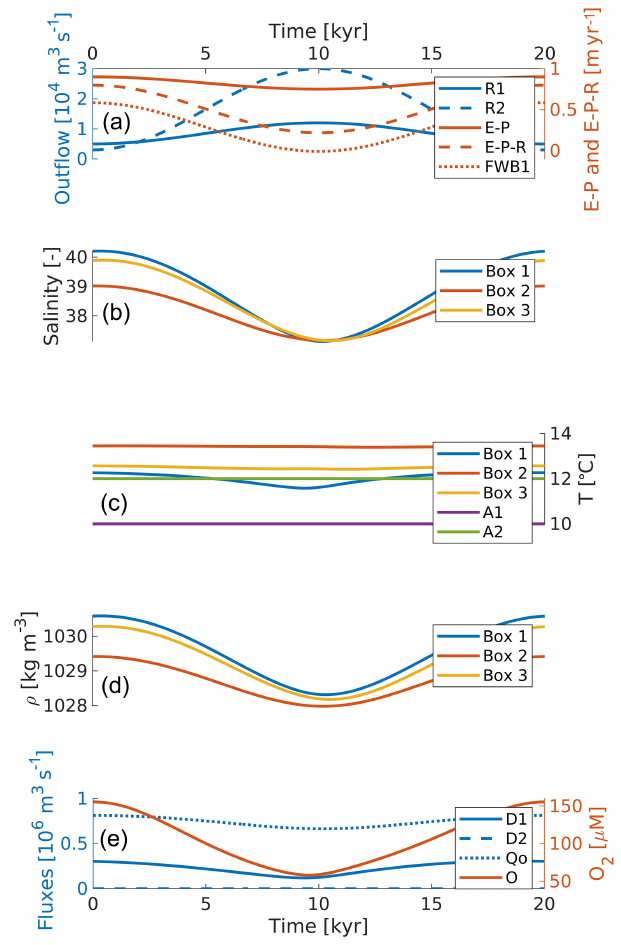
Figure 3. The forcing and results of the reference run. (a) The model forcing, with the river outflow on the left axis and the E – P , E – P – R and freshwater budget of box 1 on the right axis. (b– d) The salinity, temperatures and densities for each box, respec- tively. (e) The relevant fluxes (left axis) and the deepwater oxygen concentration (right axis). Table 2. Forcing parameters that are the same for all